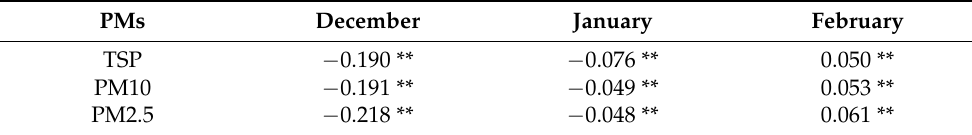
Figure 7. Temperature difference at both points. Table 10. Correlation coefficient of PMs and temperature Table 10. Correlation coefficient of PMs and temperature difference.